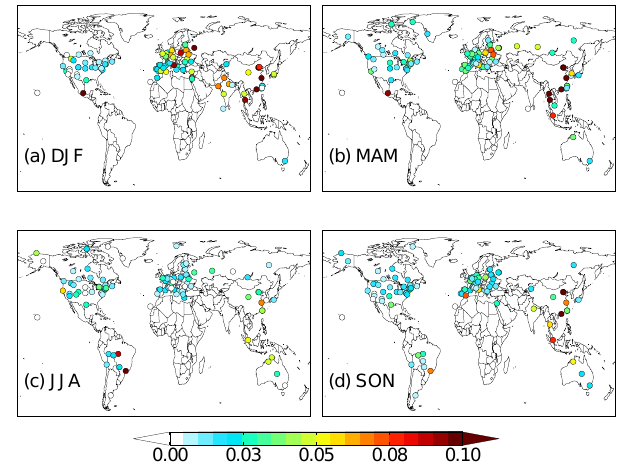
Figure 3. Derived seasonal mean BrC-AAOD at 440nm from AERONET observations (2005–2014, 10-year average) in northern hemispheric (a) winter, (b) spring, (c) summer, and (d) fall. The color bar is saturated at 0.010 to emphasize regional variations, but maximum values reach 0.056.